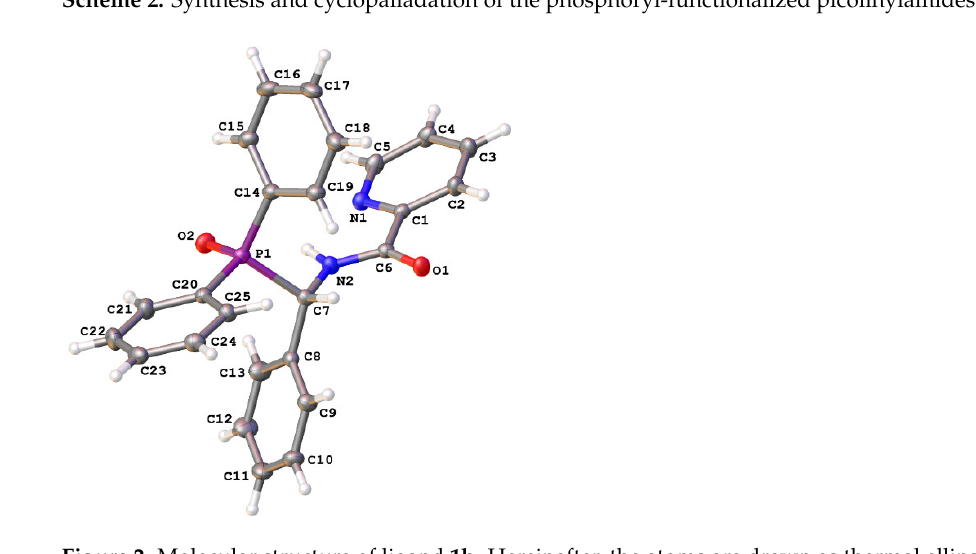
Scheme 2. Synthesis and cyclopalladation of the phosphoryl-functionalized picolinylamides.